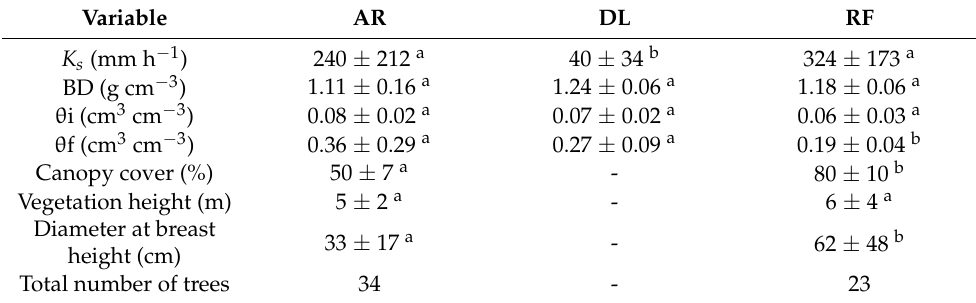
Table 1. Mean soil properties and vegetation characteristics ( ± standard deviation) of the forest sites. Different superscript letters denote statistically significant differences between land-cover types ( p < 0.05). AR, Active Restoration; DL, Degraded land; RF, Reference Forest. Variable